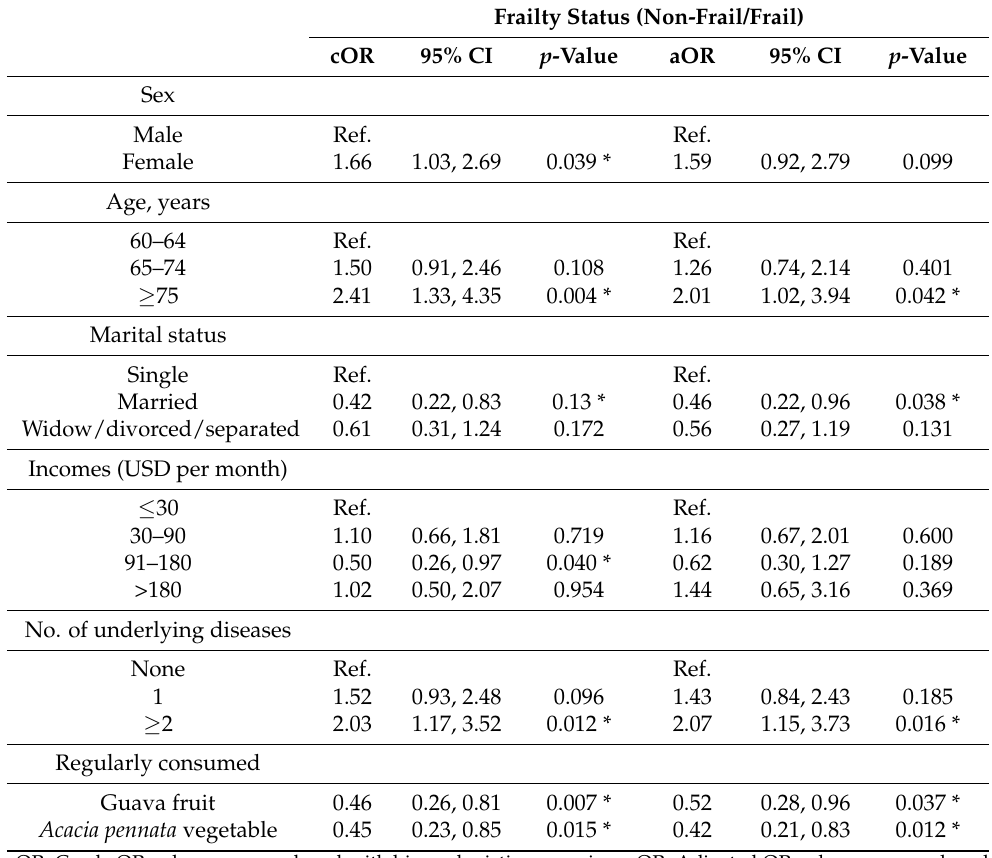
Table 4. Association between guava fruit and Acacia pennata vegetable intakes with physical frailty in older